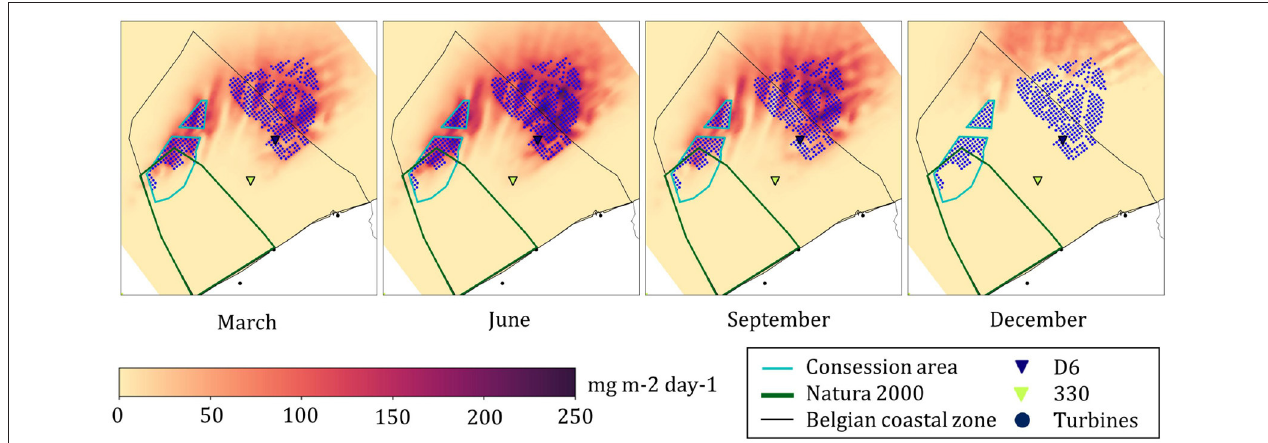
FIGURE 9 | Flux of filtered mud (FP MUD ) to the sediments for different months of the year under N-250